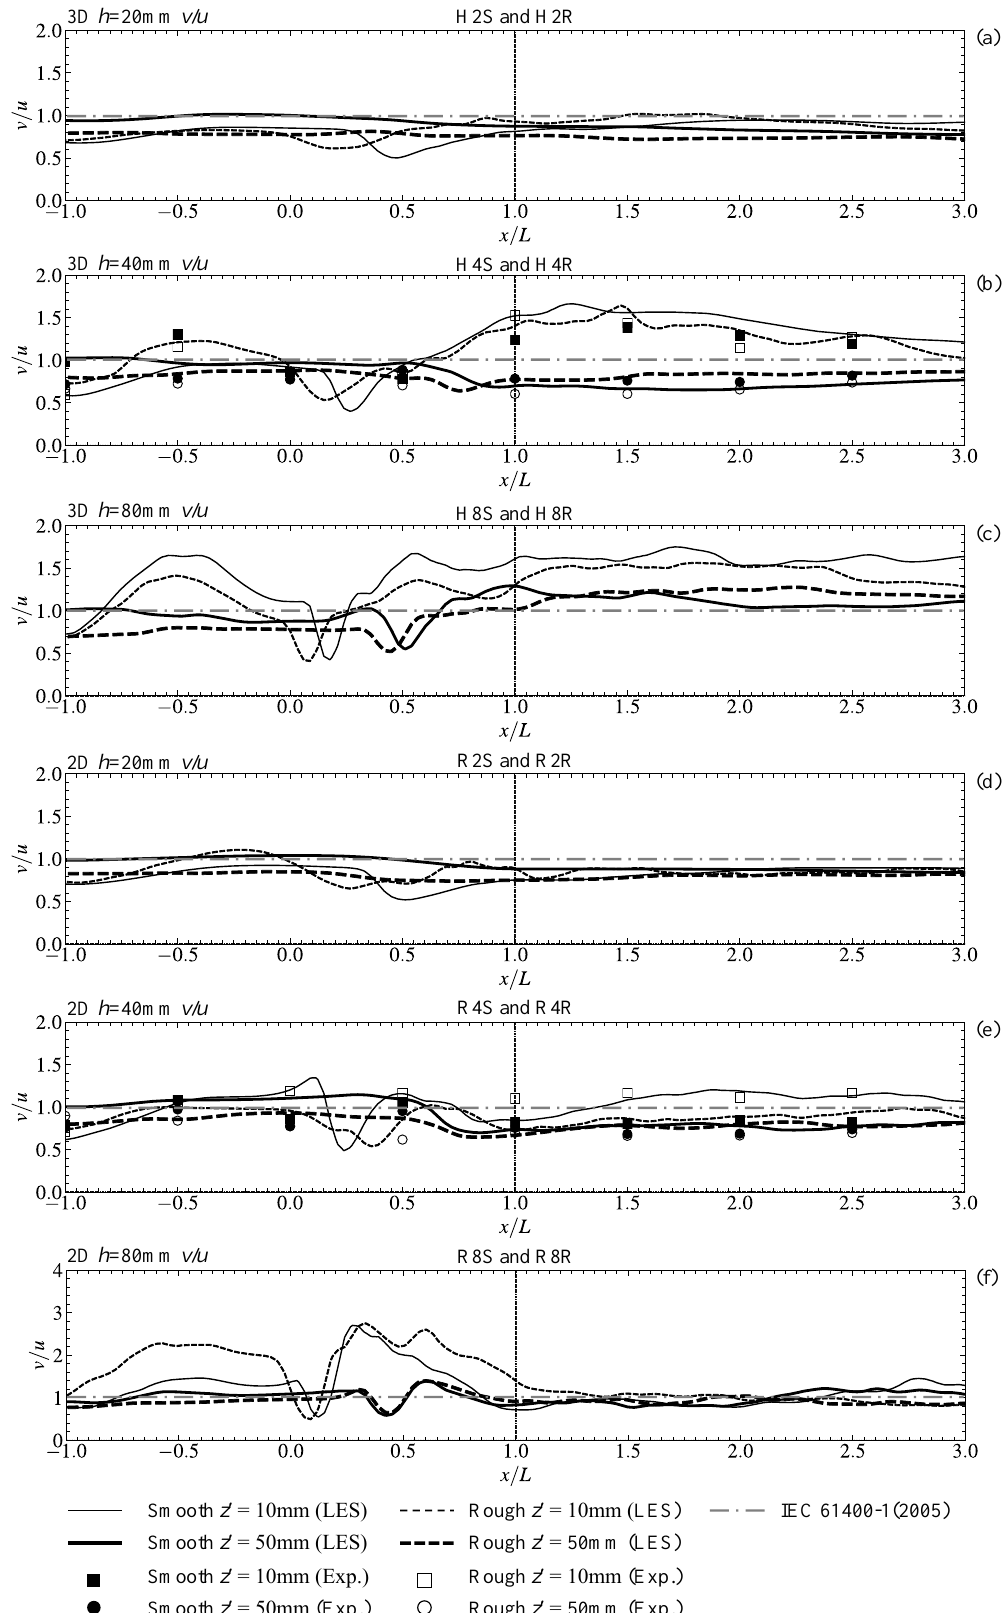
Figure 10. Fluctuation ratio v / u at z ′ = 10 mm and 50 mm, ( a ) 3D hills with h = 20 mm, ( b ) 3D hills with h = 40 mm, ( c ) 3D hills with h = 80 mm, ( d ) 2D hills with h = 20 mm, ( e ) 2D hills with h = 40 mm, and ( f ) 2D hills with h = 80 mm.